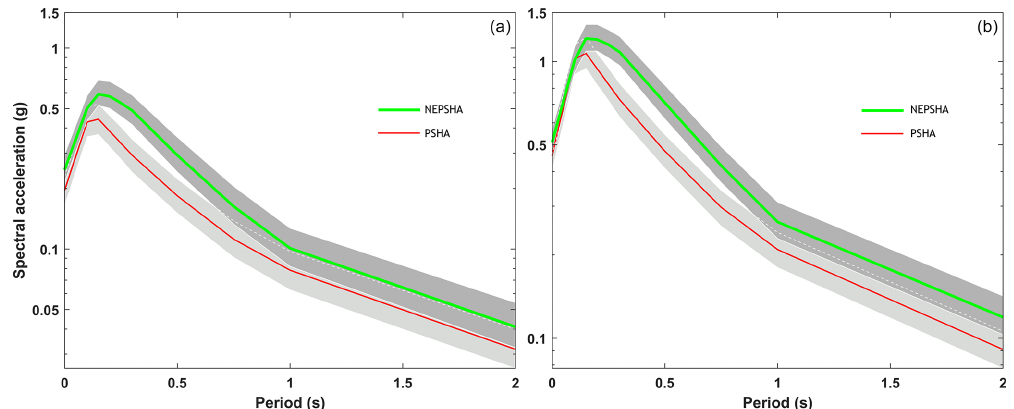
Figure 4. The uniform hazard spectra and 95% confidence intervals based on NEPSHA and PSHA for the probability of exceedance of (a) 10% in 50 years and (b) 2% in 50